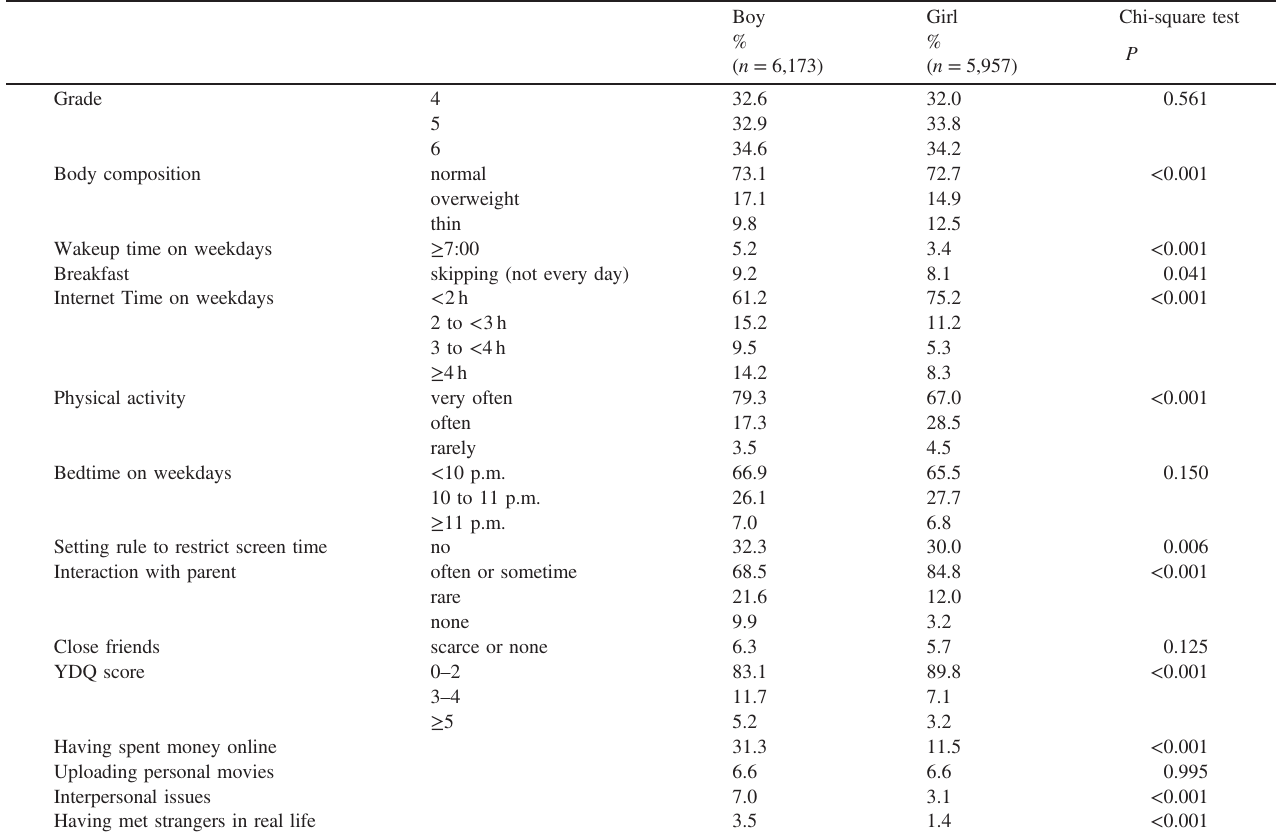
Table 1. Characteristics of children by sex, n =